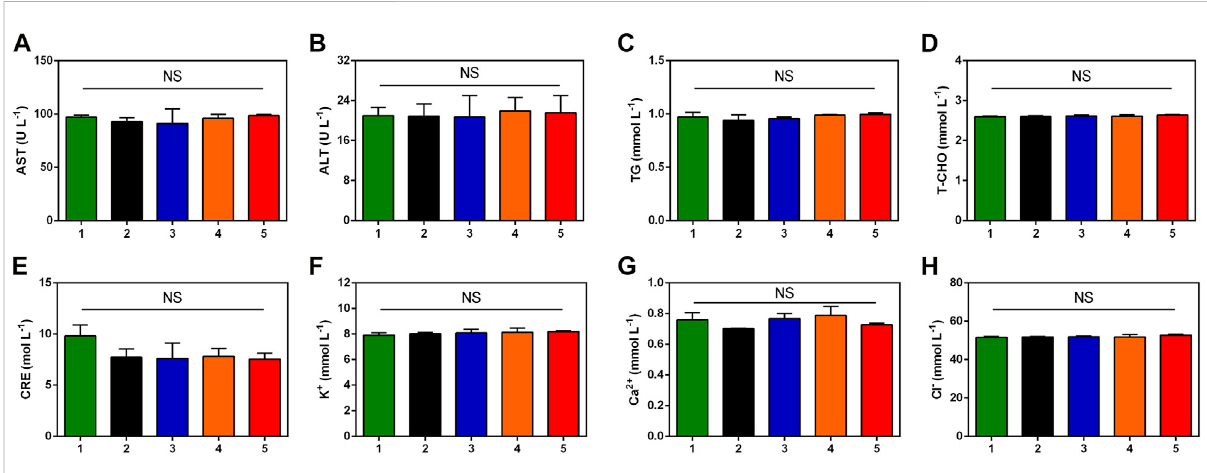
FIGURE 7 Blood biochemistry examination analysis of rats after different treatments. (A) AST (B) ALT (C) TG (D) T-CHO (E) CRE (F) K + (G) Ca 2+ (H) Cl − . Group Normal (1), Group PBS (2), Group TTVP + Dark (3), Group TTVP + Light (4) and Group LVFX (5) (NS, not signi fi